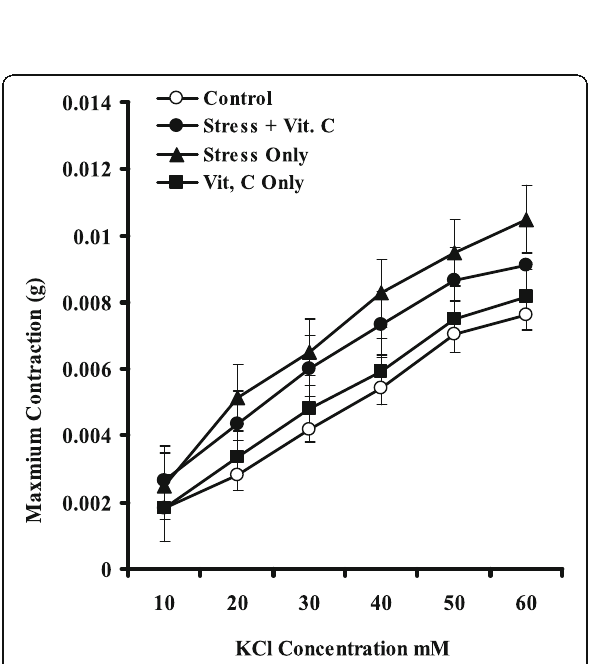
Fig. 2 Graphical representation showing the effect of chronic variable stress with vitamin C supplementation on contractile responses of testicular artery strips to potassium chloride (KCl)